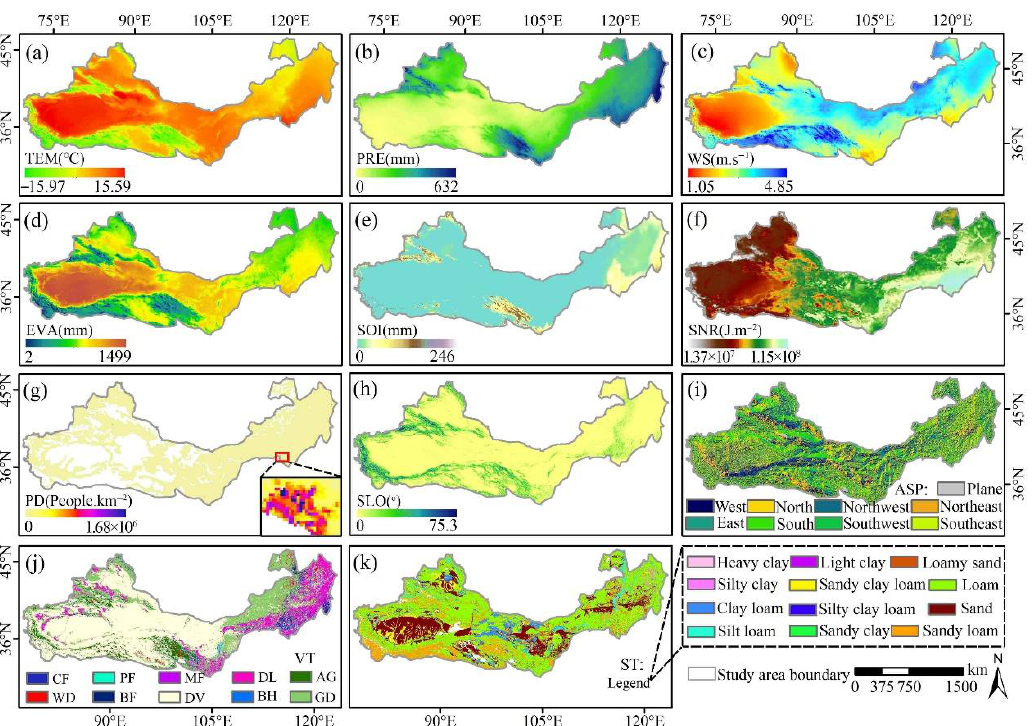
Figure 2. Spatial distribution of the 11 drivers of VEQI. CF, PF, MF, DL, AG, WD, BF, DV, BH, and GD in ( j ) represent coniferous forest, paddy field, mixed farms, dry land, alpine grassland, wetland, broad-leaved forest, desert vegetation, and bush and grassland, respectively.